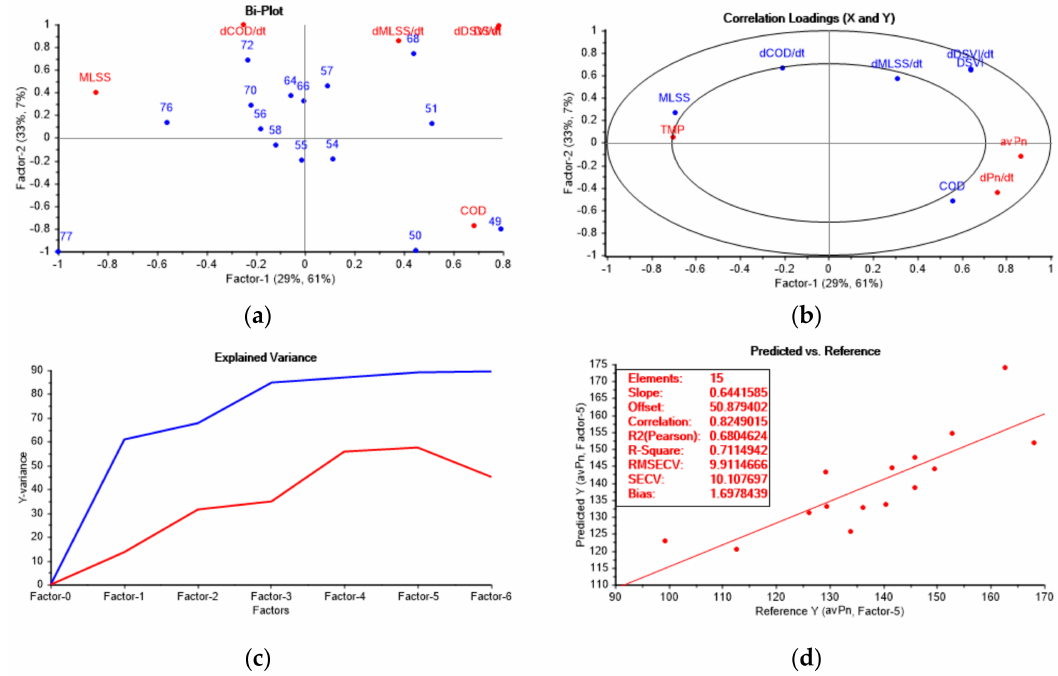
Figure 4. Results of PLS of the data from the period B of the filtration performance monitoring: ( a ) Bi-plot; ( b ) loadings plot; ( c ) explained variance plot; ( d ) fouling intensity prediction